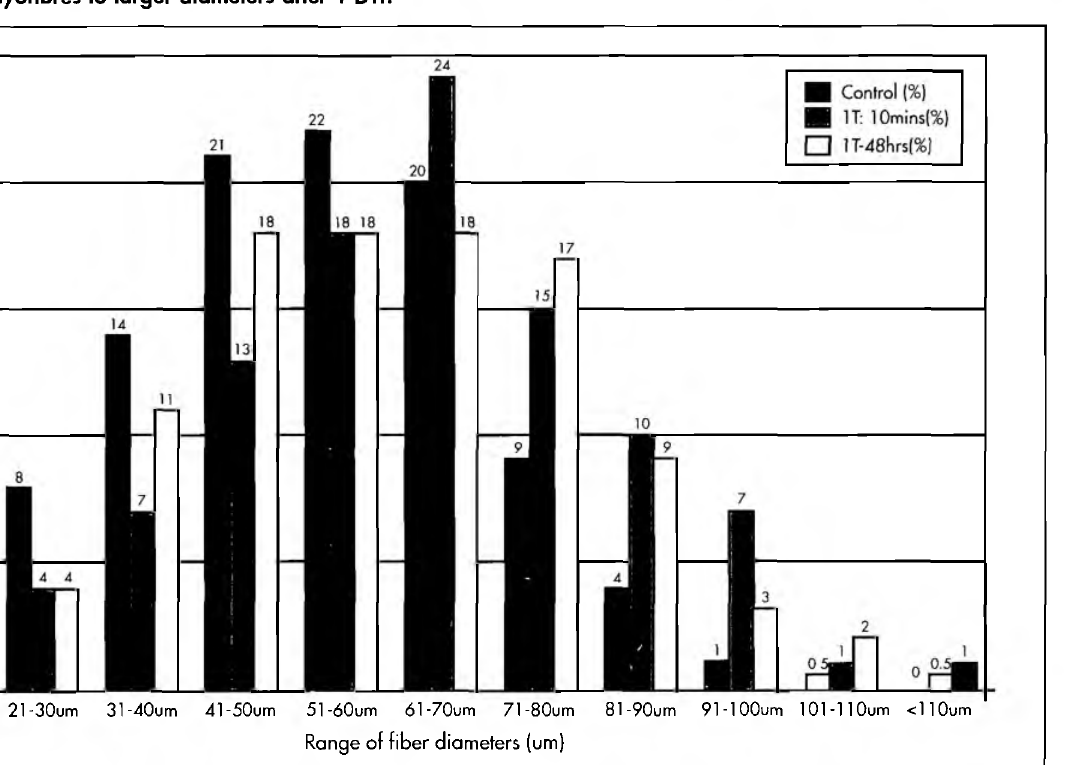
Figure 2: Bar histogram showing the distribution of fibre diameters in control muscle and tissue, 10 minutes and 48 hours after 1 DTF treatment. Note shift of myofibres to larger diameters after 1